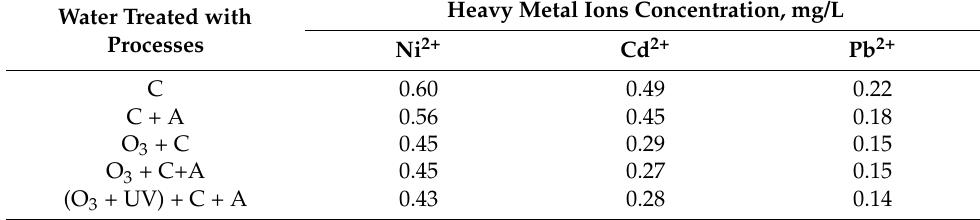
Table 9. Heavy metal ions concentration (mg/L) in modified water treated with coagulation process and hybrid processes with using powdered activated carbon (dose 50 mg/L), initial heavy metal ions concentration 1.0